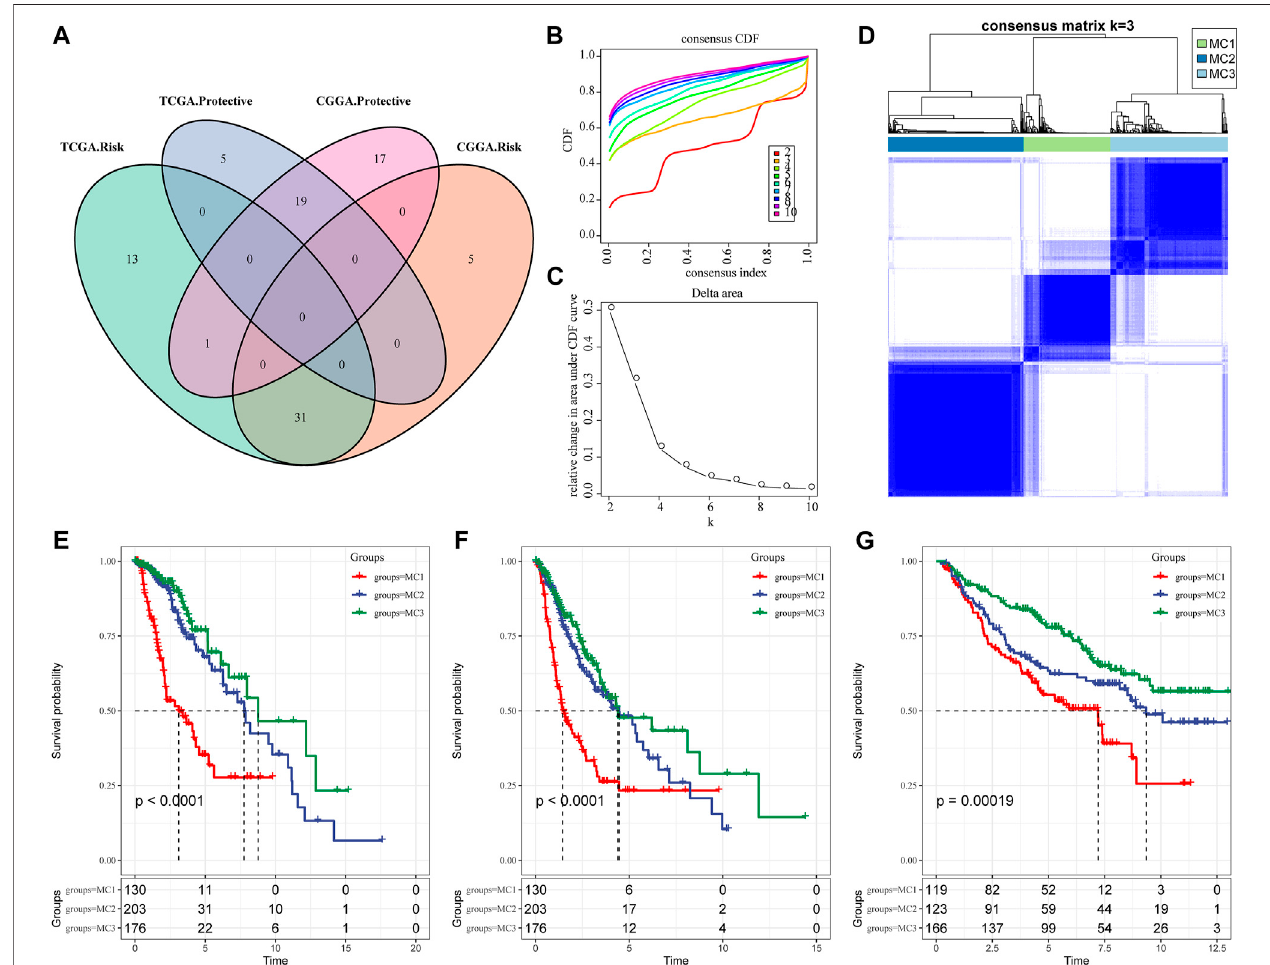
FIGURE 1 | Metabolic subtypes in LGGA. (A) The intersection of prognostic metabolic signatures between TCGA and CGGA. (B) CDF curve of the TCGA cohort. (C) CDF delta area curve. The horizontal axis represents the category number k and the vertical axis represents the relative change in area under the CDF curve. (D) Sample clustering heatmap, k (cid:1) 3. (E) Overall survival curve of three metabolic subtypes in the TCGA cohort. (F) PFS curve of metabolic subtypes in TCGA cohort. (G) OS curves of three subtypes in the CGGA cohort.